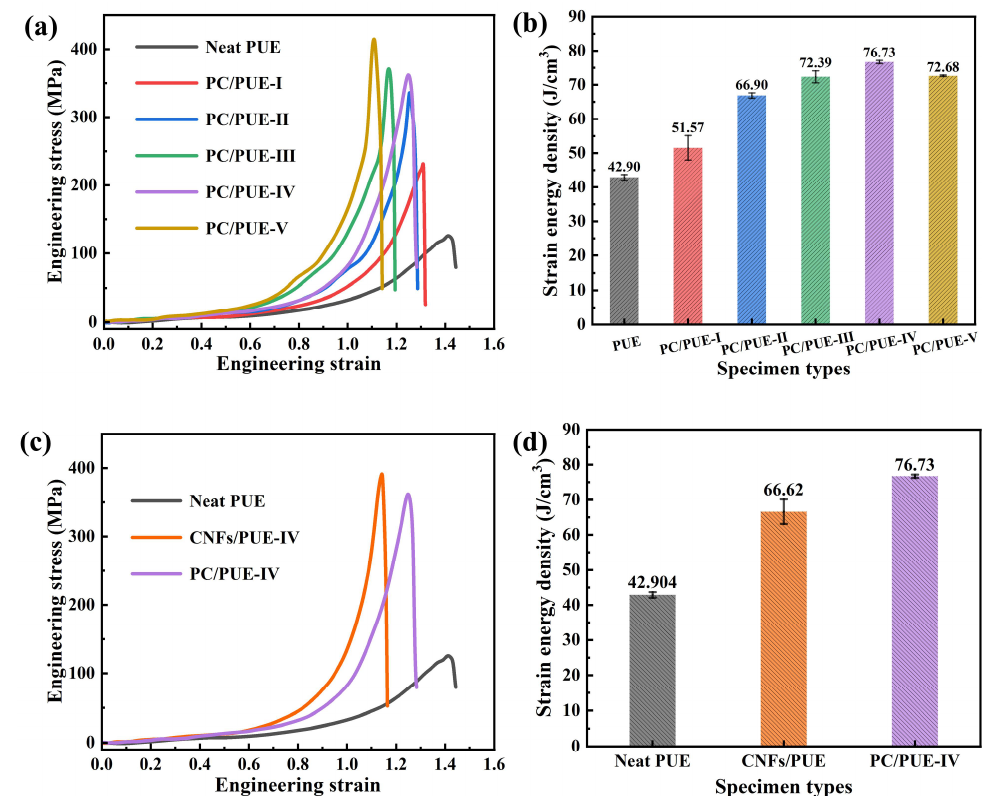
Figure 7. ( a ) Pictures of neat PUE, CNFs/PUE and PC/PUE-IV after SHPB test (from left to right), magnified pictures of ( b ) the neat PUE, ( c ) CNFs/PUE, ( d ) PC/PUE–IV. ( e ) Optical microscope image of PC/PUE–VI.